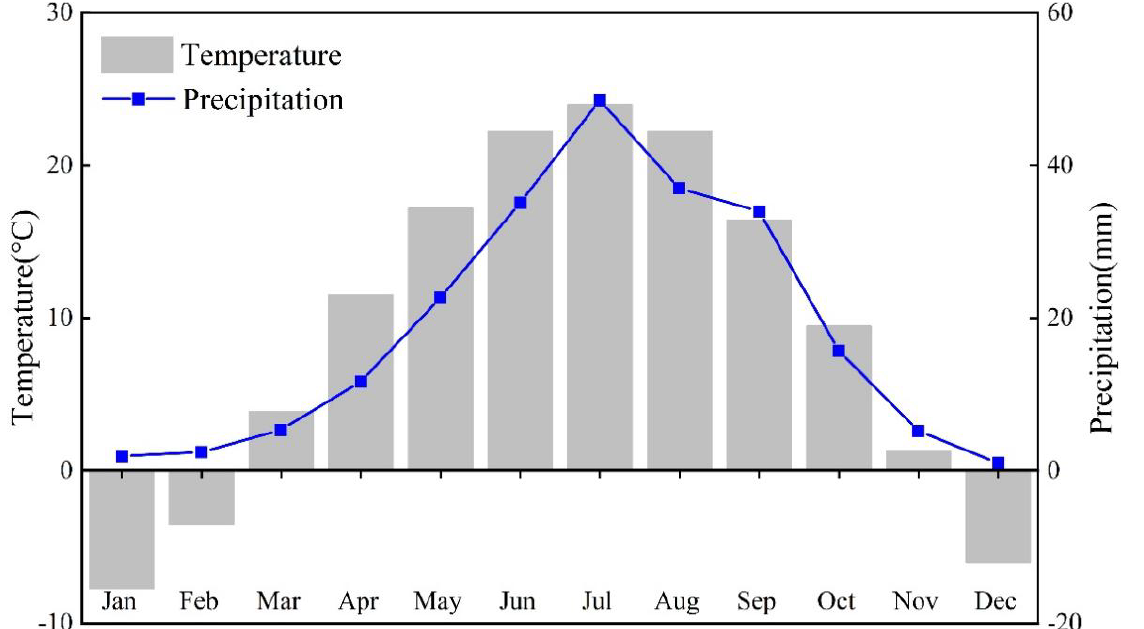
Figure 2. Intra − annual distributions of mean temperature and precipitation from 2005 to 2019.